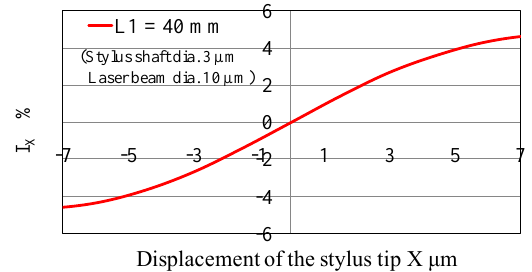
Fibers 2016 , 4 , 24 Figure 12. Simulation result for I Y for a distance of L 1 = 40 mm ( X displacement of the stylus tip).